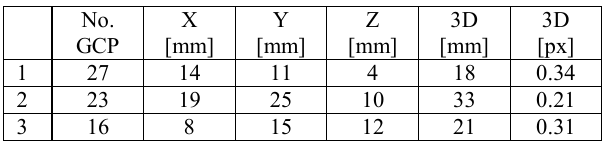
Table 3. Overall GCP errors